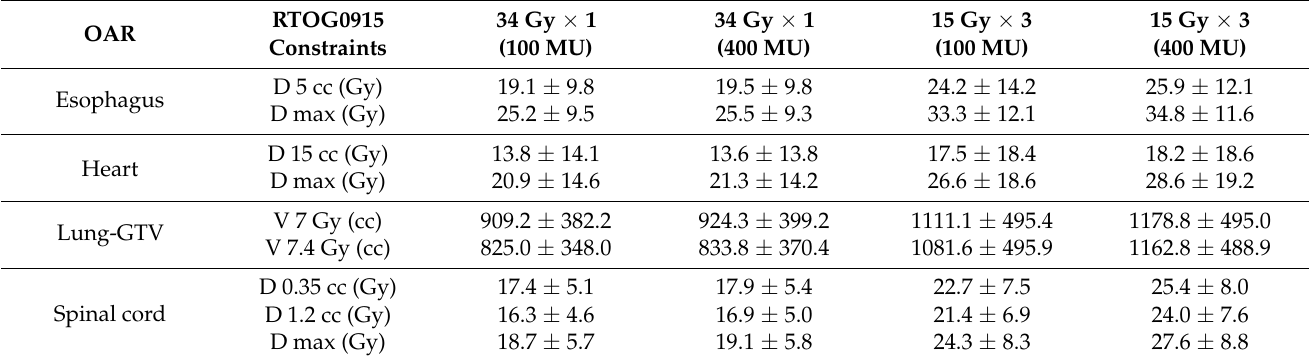
Table 1. OAR dose metrics for all transmission plans (RTOG0915 metrics are